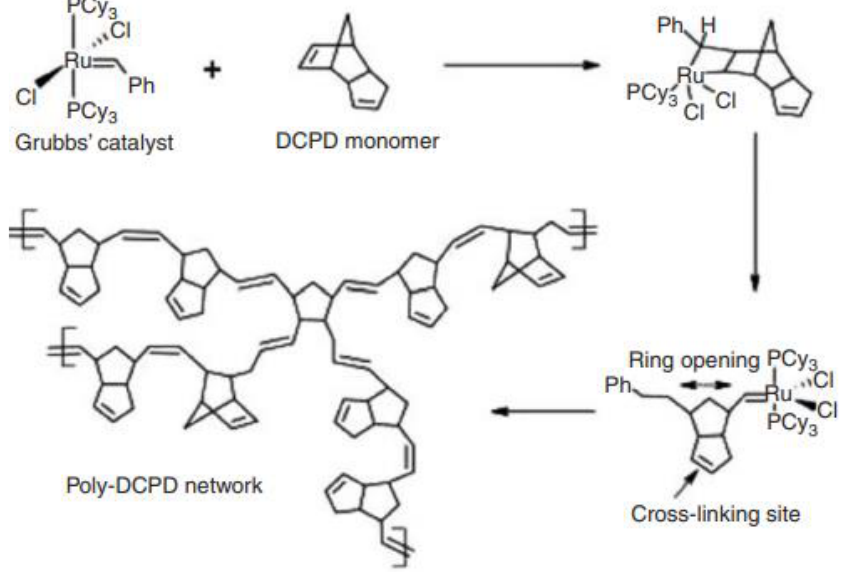
Figure 3. ROMP (Ring opening metathesis polymerization) of DCPD [6].